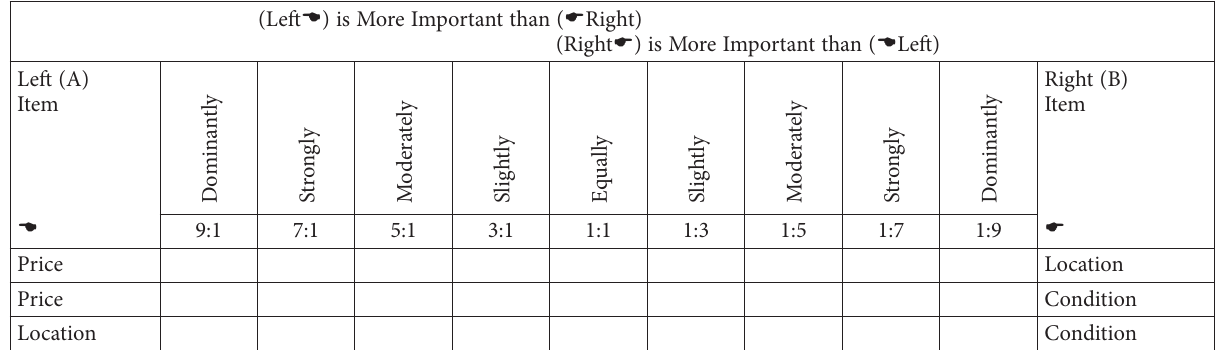
Table 2. Block 2 in the questionnaire